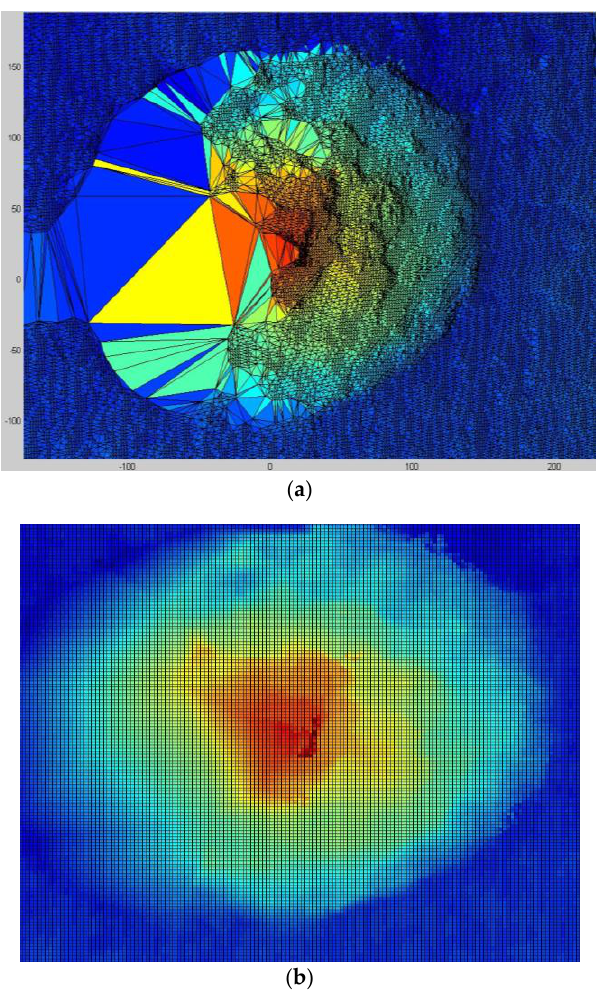
Figure 9. Reconstruction of the 3D surface: ( a ) Surface of the concrete slump generated by the triangulated irregular network (TIN); ( b ) Surface of the concrete slump in grid coordinate (Result of triangulation-based linear interpolation for TIN).